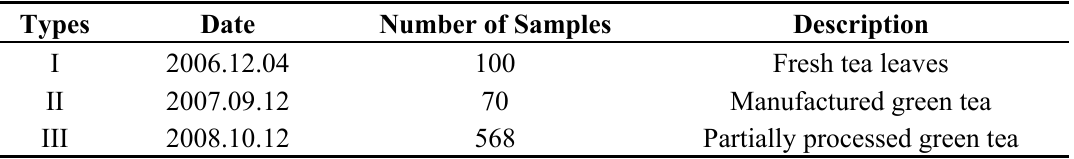
Table 1. General information of the three types of samples.